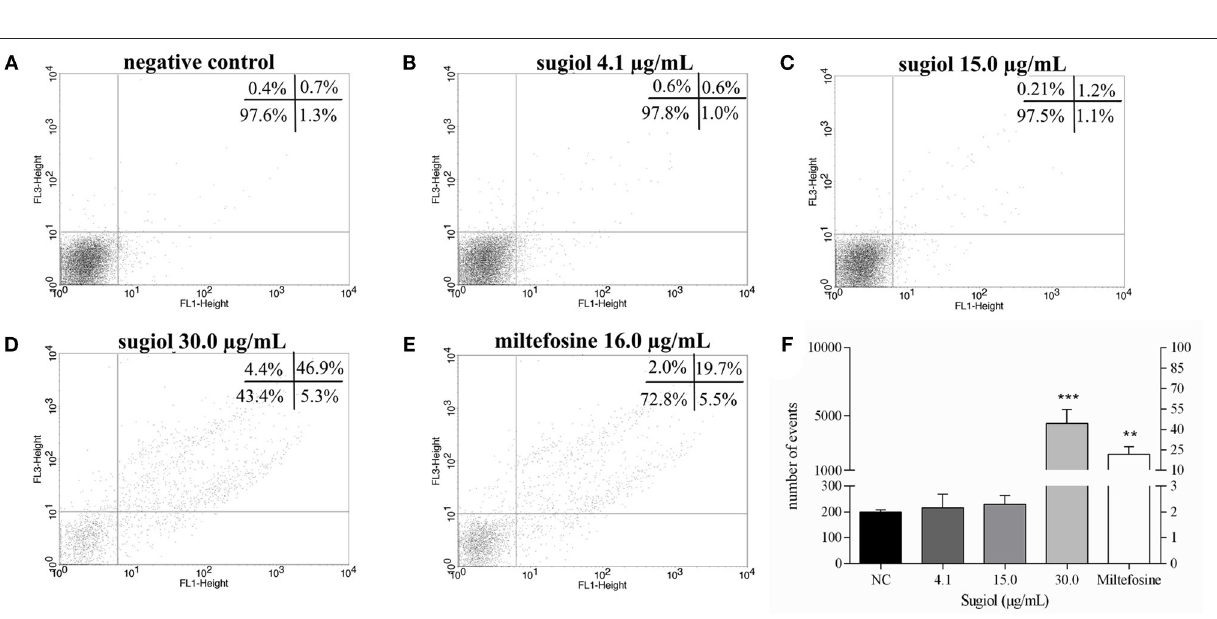
Frontiers in Cellular and Infection Microbiology |